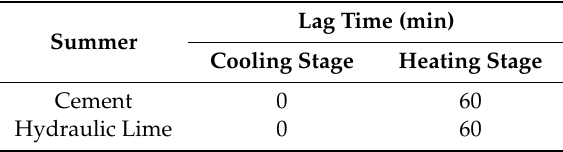
Table 3. Lag time between the maximum and minimum temperatures in summer climate.